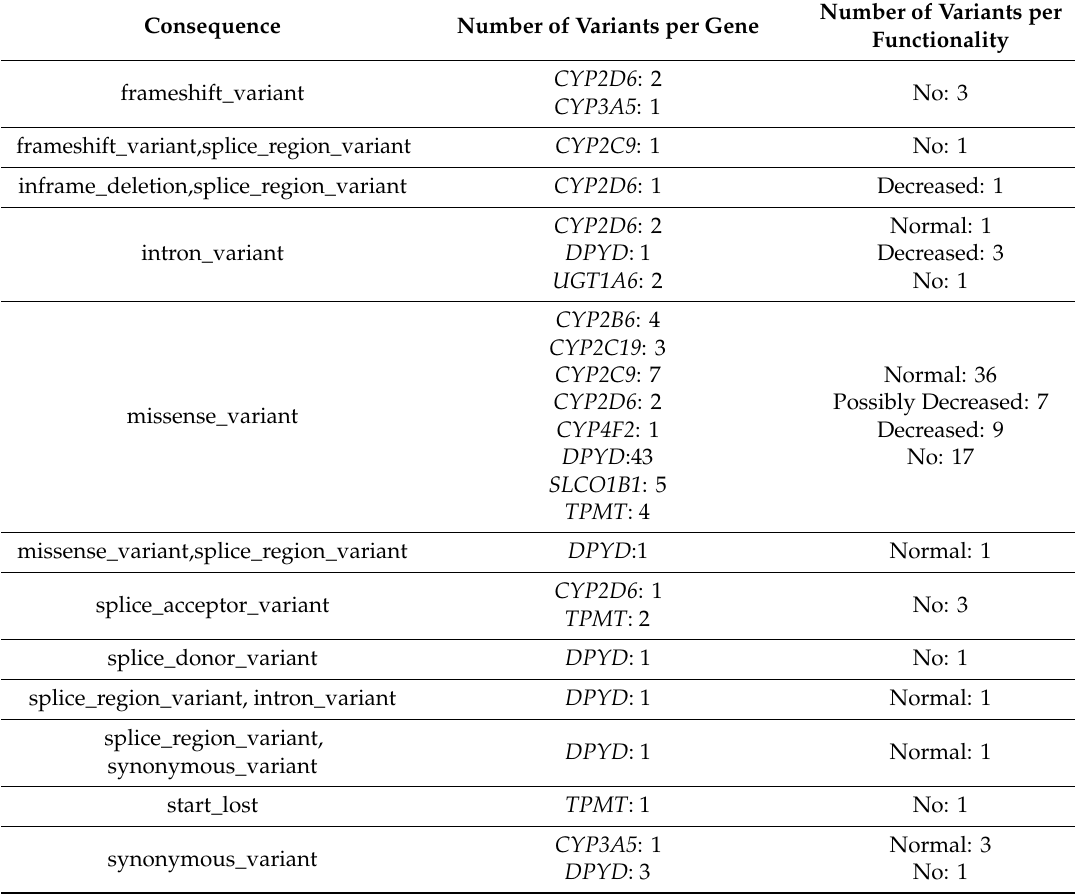
Table 3. Distribution of the 91 variants, which were found both in the DiscovEHR dataset and the gene-specific tables from PharmGKB, based on their VEP consequence based on Sequence Ontology terms. The distribution is shown on a gene level and on a pharmacogene (PGx gene) family level. Number of Variants Consequence Number of Variants per Gene